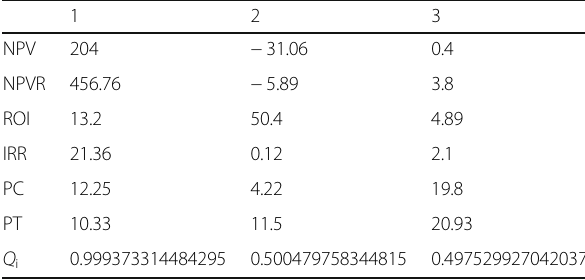
Table 3 The results of the testing